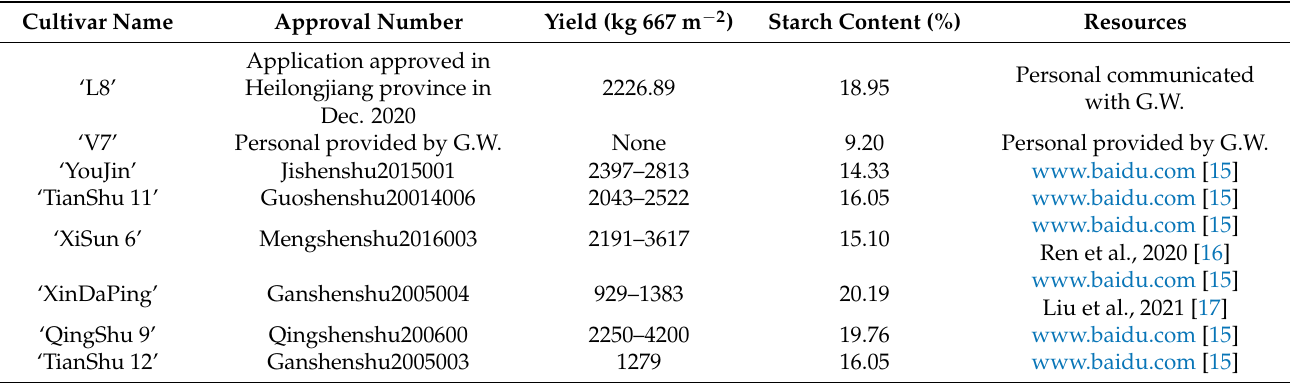
Table 1. Basic information of potato cultivars used in this